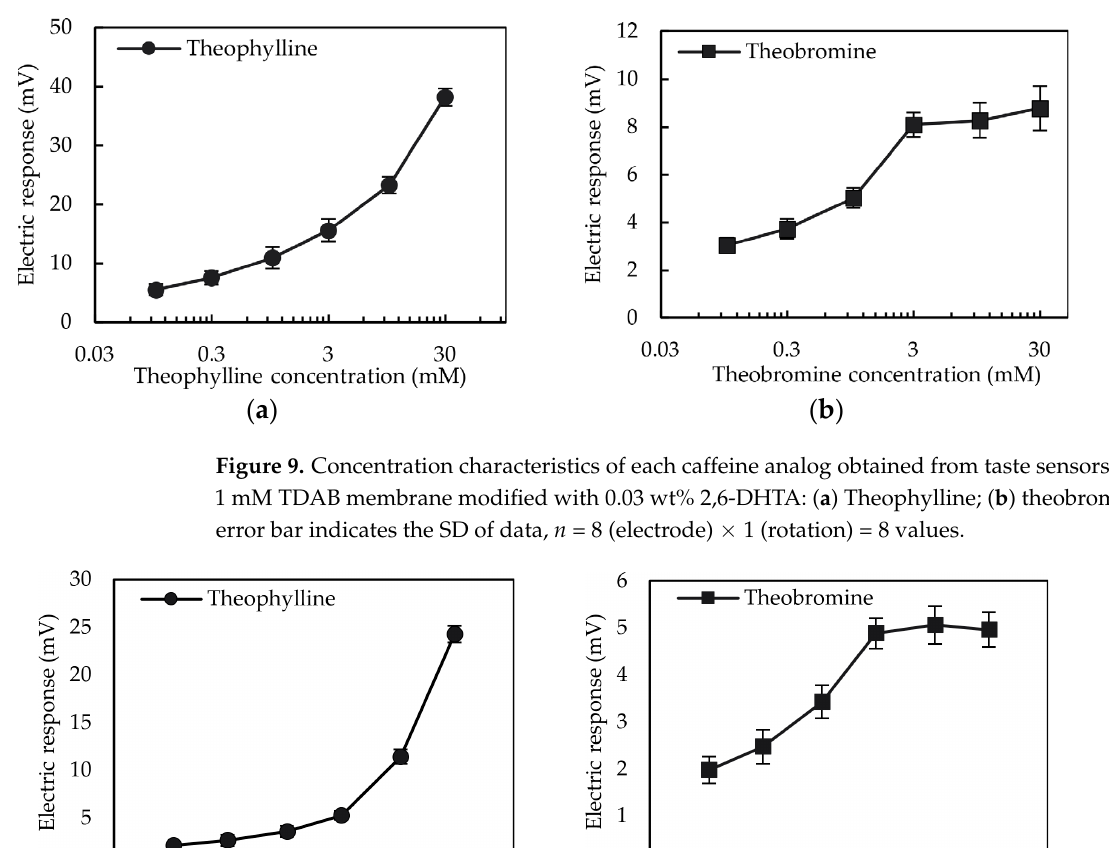
Chemosensors 2023 , 11 , x FOR PEER REVIEW